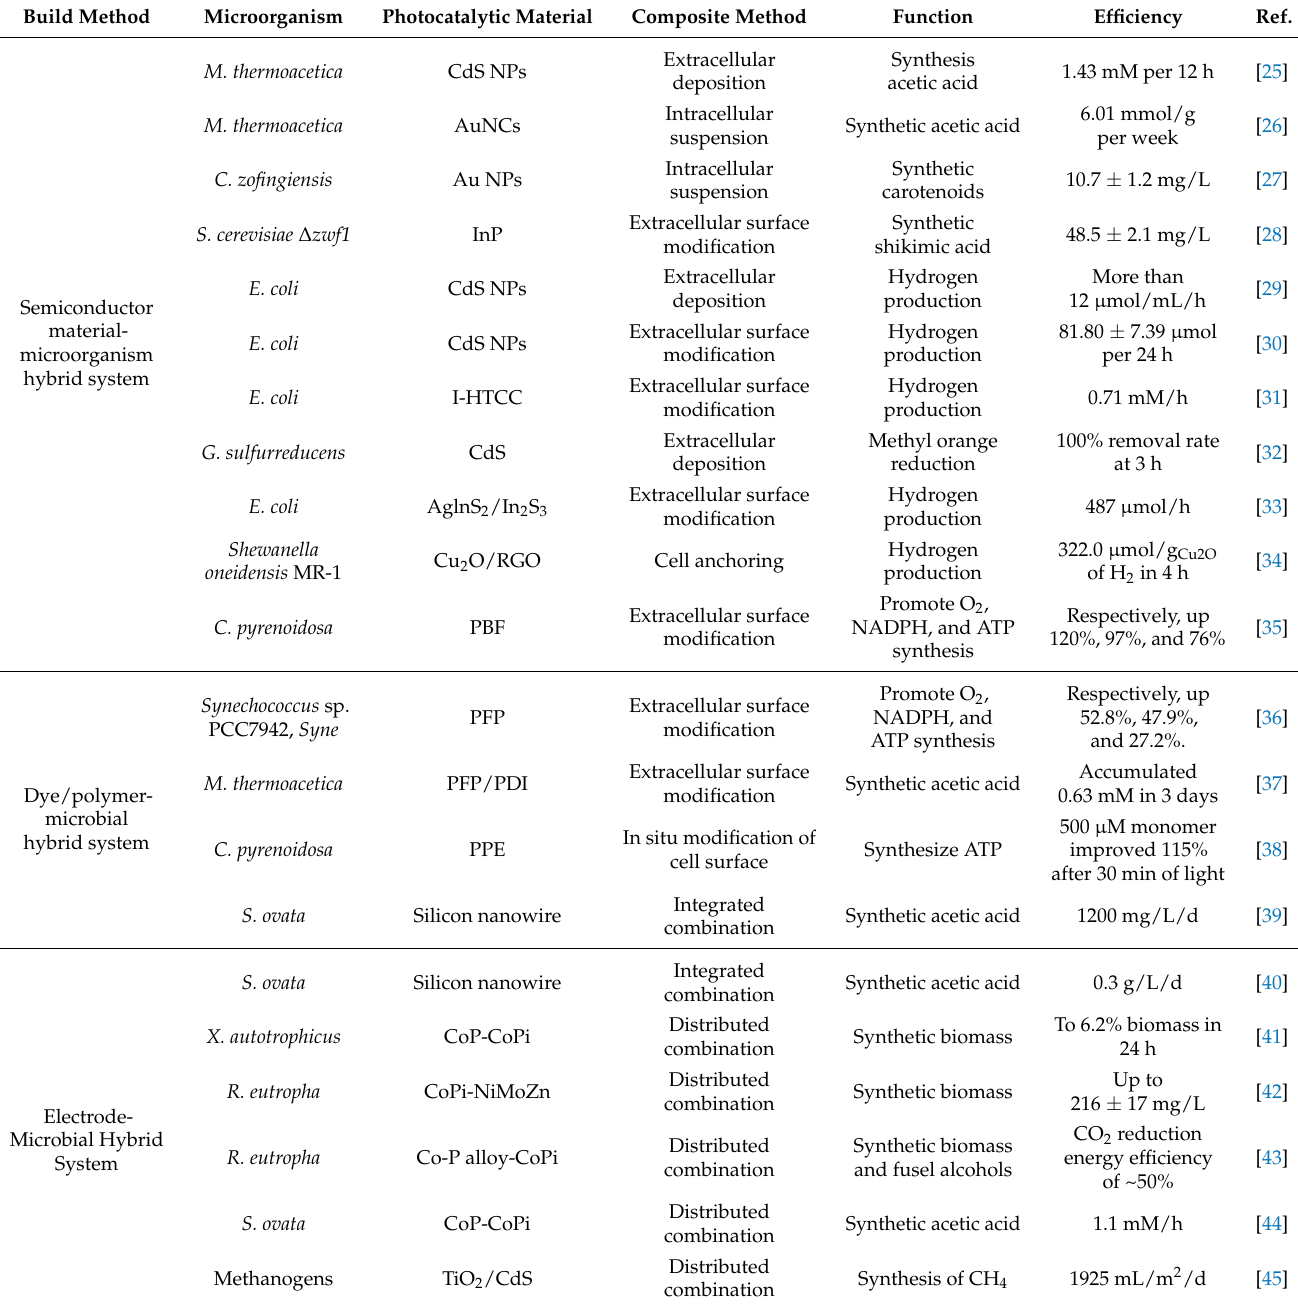
Table 1. The typical photocatalytic material-microbe hybrid